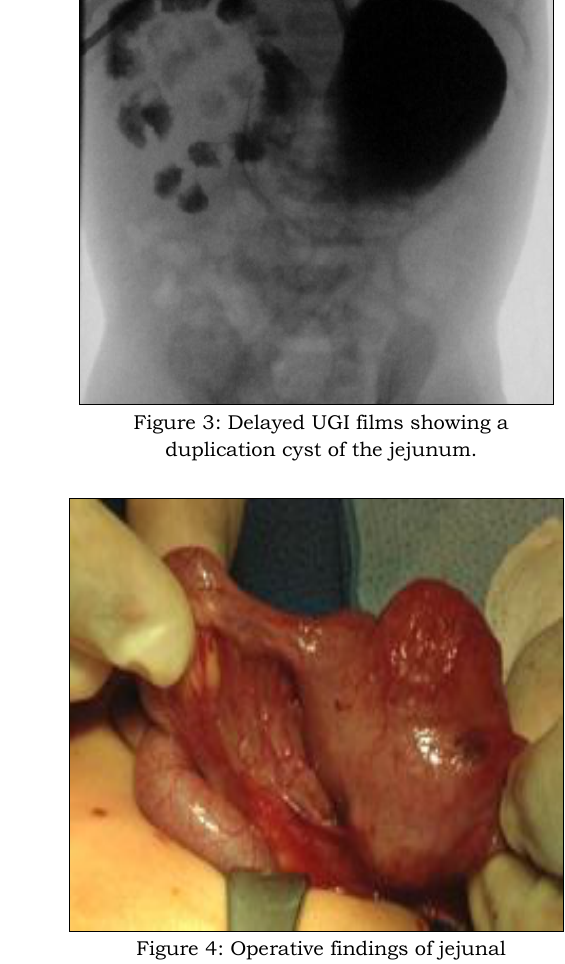
Figure 1: 22wk prenatal US showing pseudo double bubble.